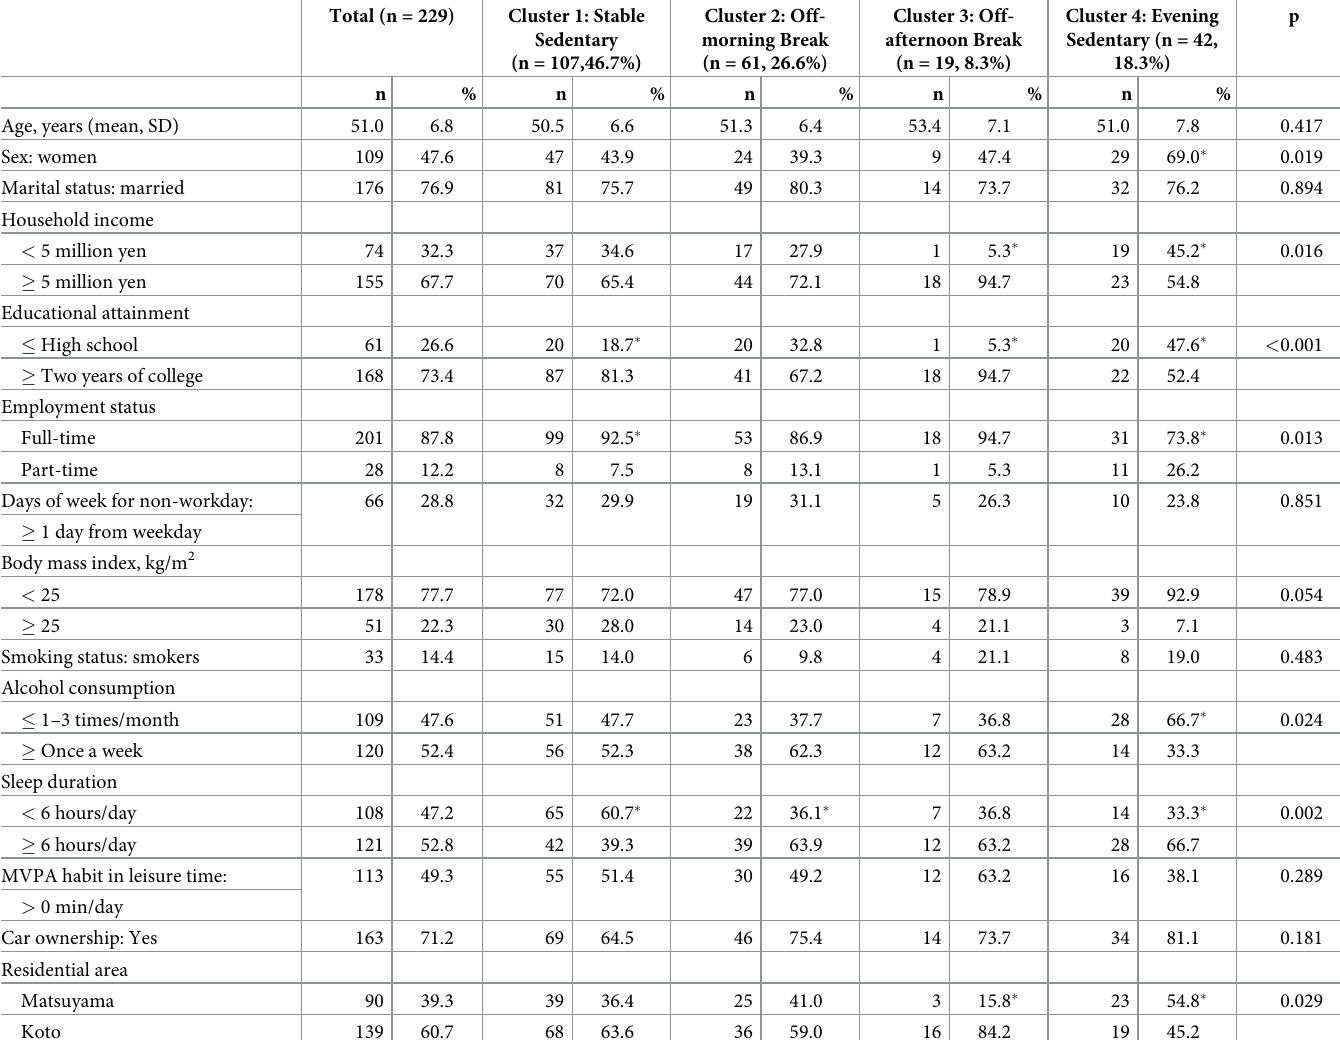
Table 1. Characteristics of participants in four